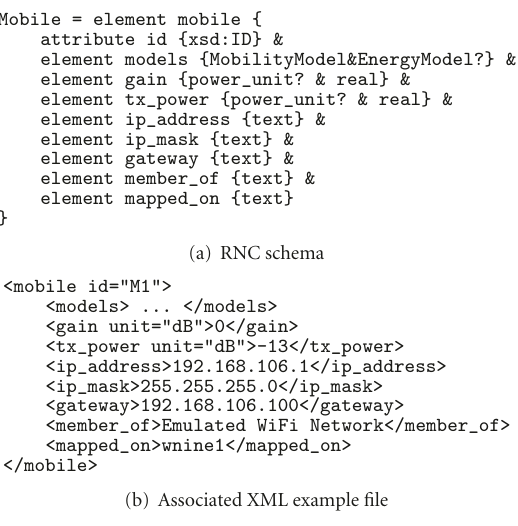
Figure 5: An excerpt of the HLD file for